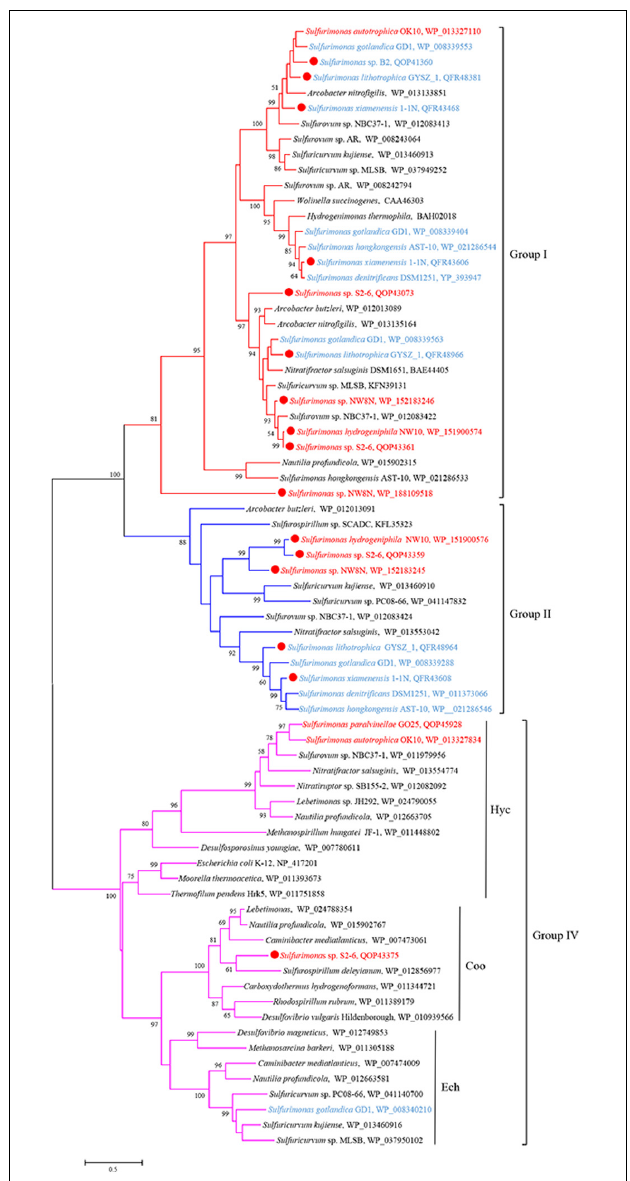
FIGURE 6 | Maximum likelihood phylogenetic tree of hydrogenase large subunit sequences derived from Sulfurimonas strains and other representative species within the class Campylobacteria . Bootstrap values indicated at each node are based on a total of 1,000 bootstrap replicates. Branch node values below 50% are not shown. The solid red circles represent our own isolated strains. Branches representing different hydrogenase group are different color. Isolation sources of Sulfurimonas species are indicated in different font colors: red, hydrothermal environments; blue, marine non-vent